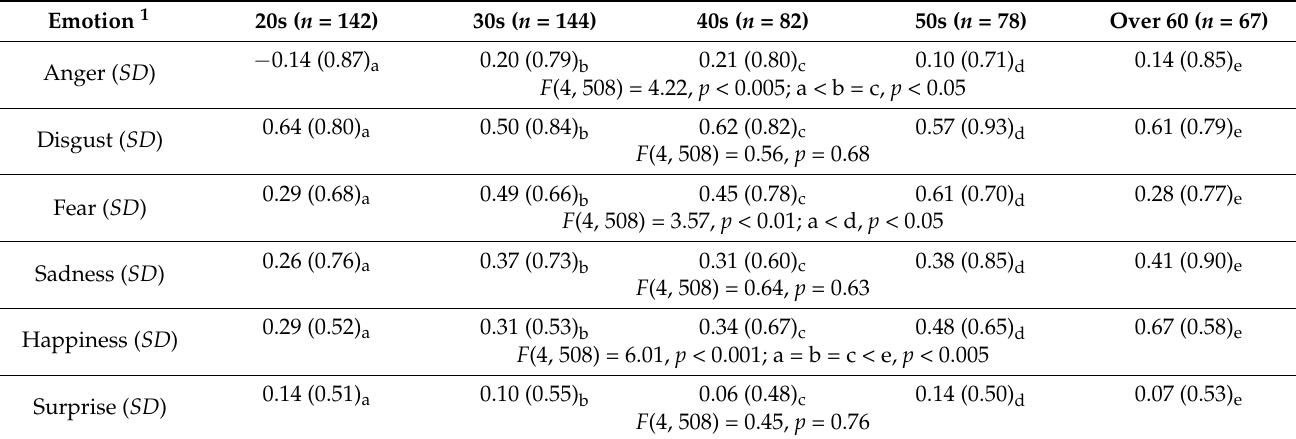
Table 3. Investigation of participants’ age-related difference in accuracy difference indexes.